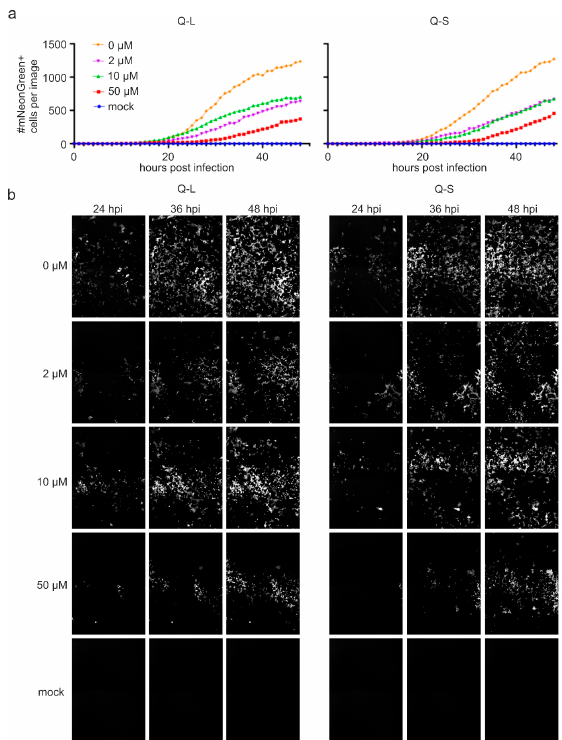
Figure 4. Influence of quinine (a + b) on the cell viability of CaCo-2 cells. Similar to the drug treatment scheme described in Figure 2, the influence on cell viability was measured by WST-1 assays. Quinine-sulfate was used as ( a ) Q-L or ( b ) Q-S. Bars represent mean values of 3 independent experiments ±SD. Taking advantage of the possibility to monitor viral spread in living cells, we im- aged cells infected with icSARS-CoV-2-mNG and treated with Q-L/Q-S over a period of 48 h in 1 h intervals (Figure 5). Of note, quinine treatment strongly delayed as well as suppressed viral spread and SARS-CoV-2 replication in Caco-2 cells (Figure 5 as well as Supplemental Movies S1 and S2). Hence, quinine is effective against SARS-CoV-2 in human colon cells, and this inhibitory effect occurs early during infection and even at high virus doses of initial infection.